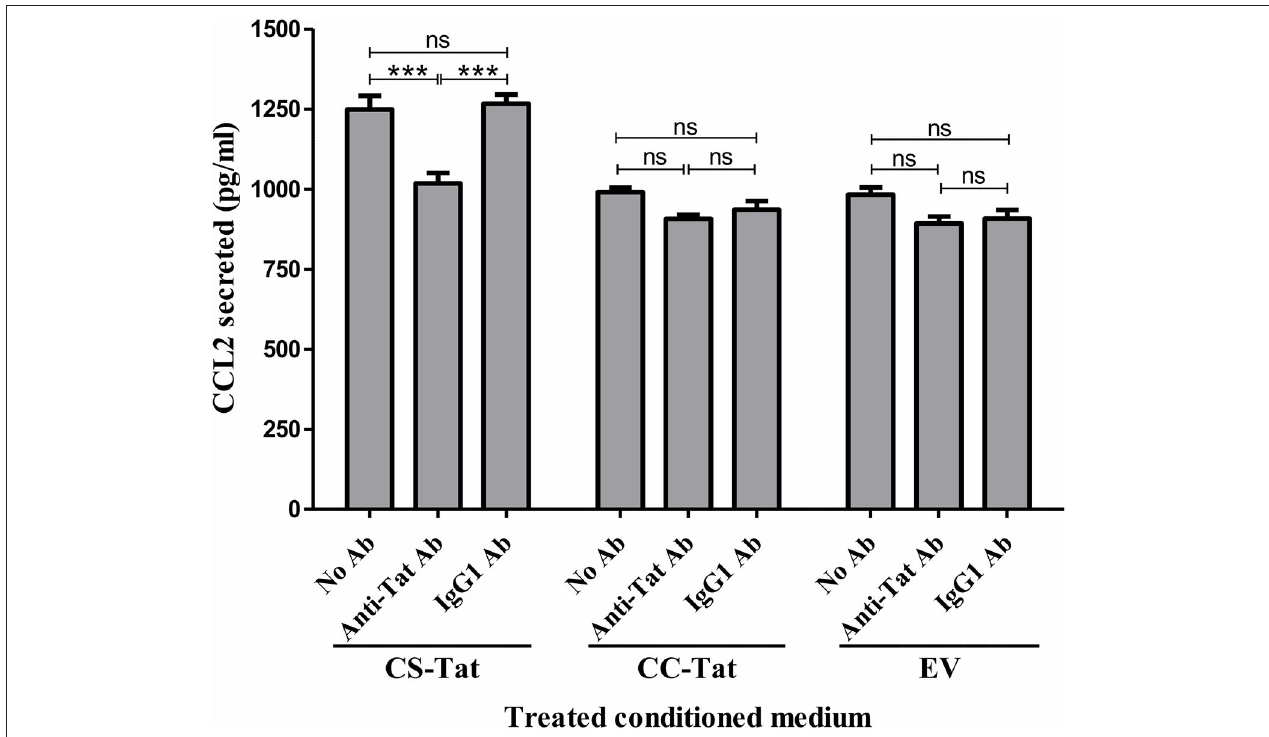
FIGURE 3 | Tat neutralization in the conditioned media attenuates S31-specific differential CCL2 secretion. Conditioned media were collected from Jurkat-Tat cells at 12h following Dox induction. The conditioned media were incubated with a highly potent anti-Tat monoclonal antibody (1 µ g/ml of E2.1 antibody, raised in-house) or an IgG1 isotype control antibody or “no antibody” for 30 min at room temperature with gentle agitation. The HUVEC were exposed to the Tat-neutralized conditioned media for 12h, and the CCL2 secretion was quantified using ELISA. EV: empty vector control. Two-way ANOVA with Bonferroni post-test (*** p <